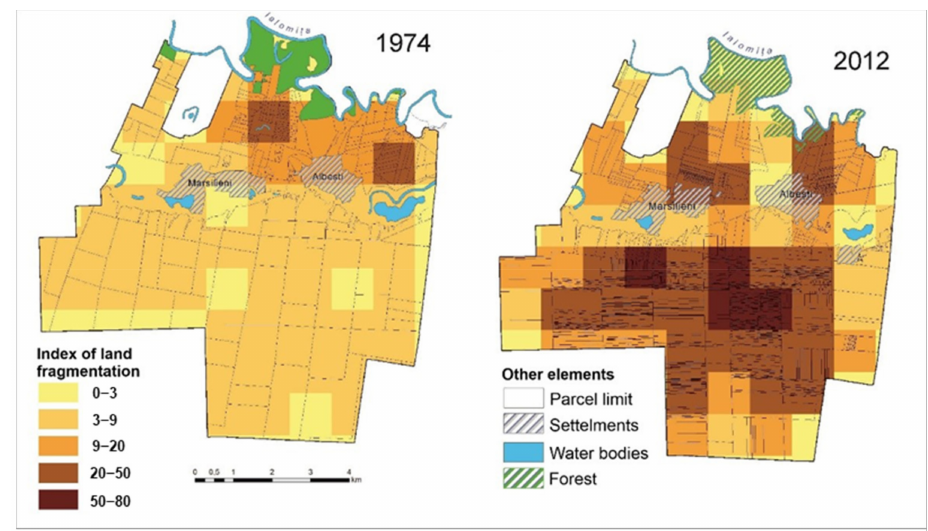
Figure 12. The index of land fragmentation in 1974 and 2012 (Albes